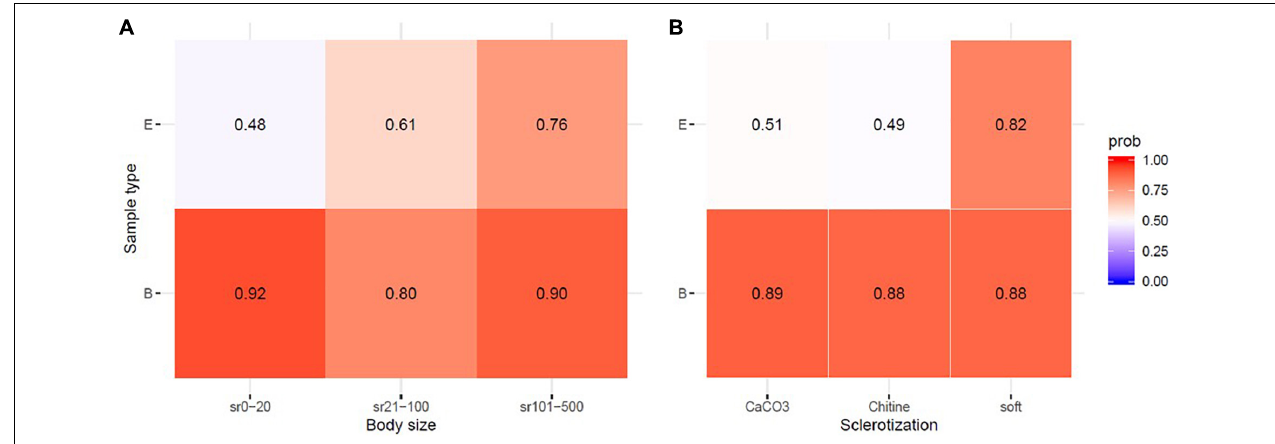
FIGURE 5 | Effect of sample type, body size and sclerotization on the probability of detecting macrobenthos species in bulk DNA (B) or eDNA from the ethanol preservative (E) in relation to body size (A) and sclerotization (B) . Probabilities are based on the generalized linear mixed effects model in Table 3 .